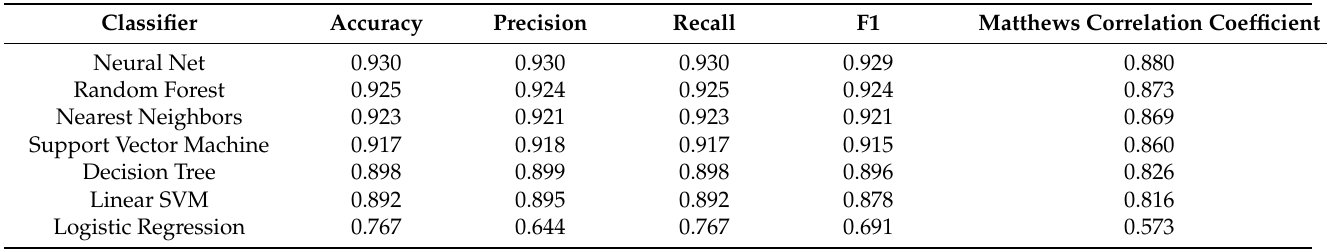
Table 7. Comparison of the accuracy metrics for supervised algorithms trained and evaluated on a dataset without F4 and